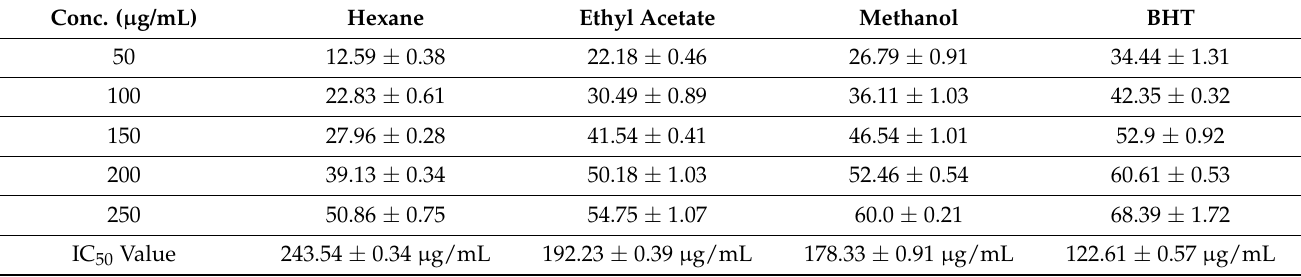
Table 5. Superoxide radical scavenging activity of different extracts of A. chasmanthum rhizome.